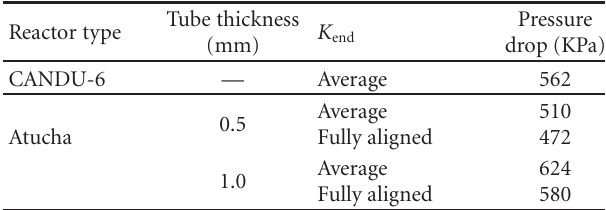
Table 13: Estimated CARA fuel channel pressure drop under dif- ferent